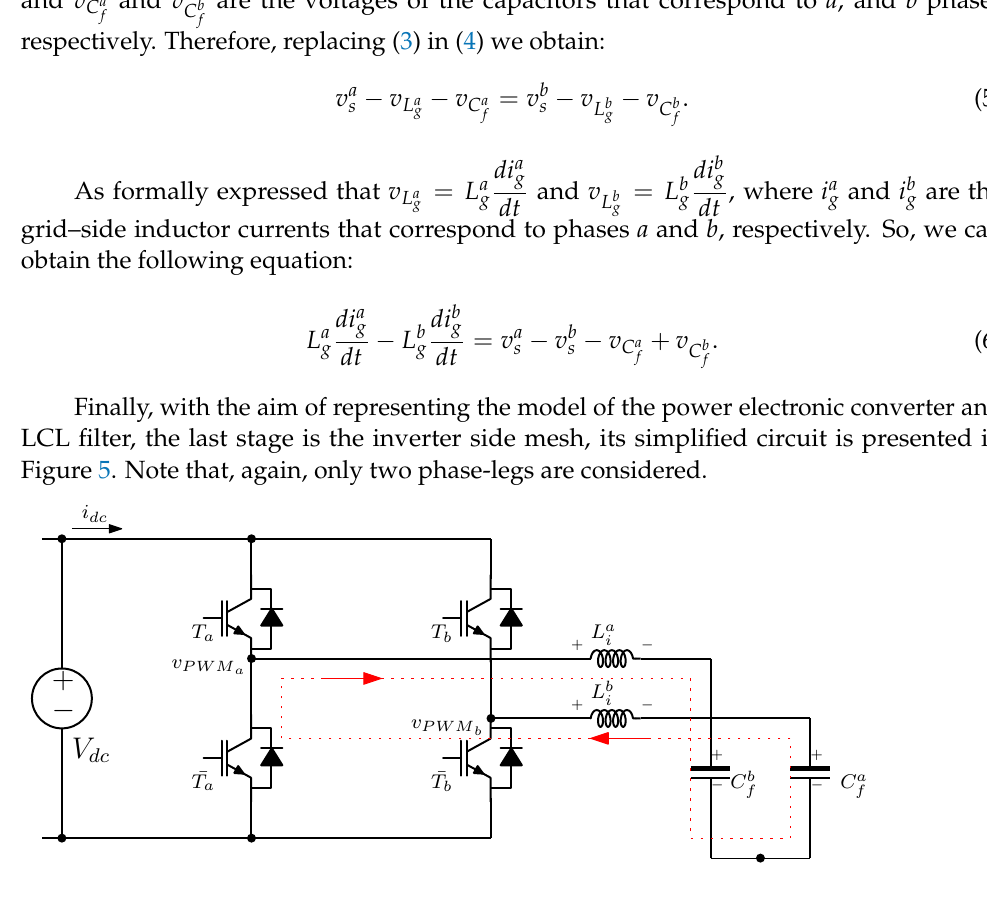
Figure 5. Inverter–side mesh: simplified